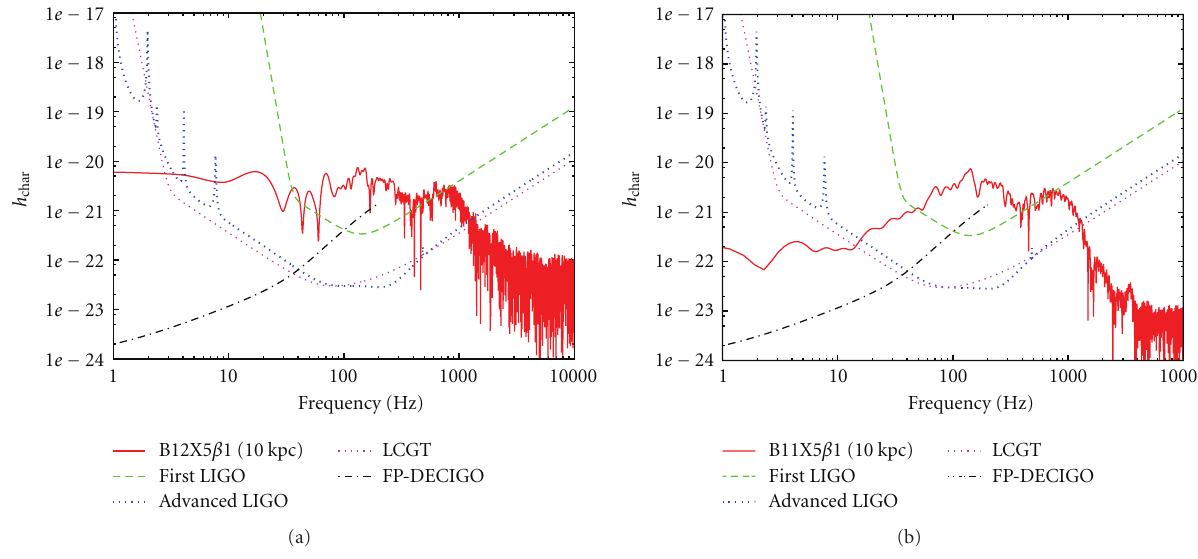
Figure 24: Gravitational-wave spectrum for representative models with the expected detection limits of the first LIGO [11], the advanced LIGO [304], Large-scale Cryogenic Gravitational wave Telescope (LCGT) [216], and Fabry-Perot type DECIGO [217, 305]. It is noted that h char is the characteristic gravitational wave strain defined in [218]. The supernova is assumed to be located at the distance of 10 kpc. This figure is taken from [219].